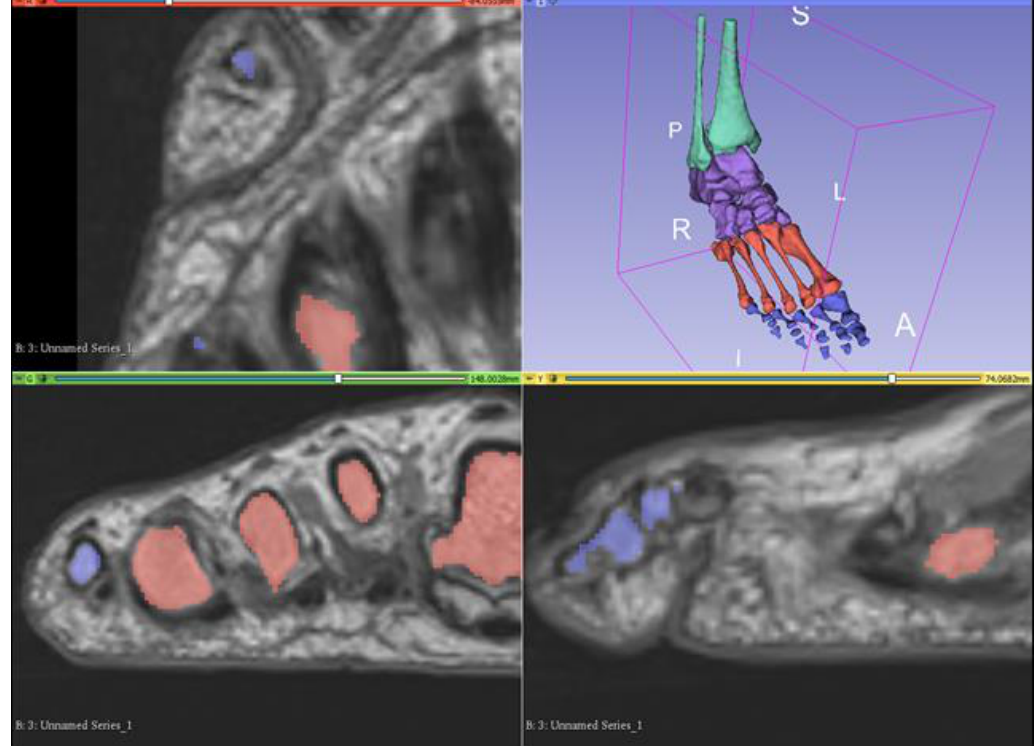
Figure 4. Completed bony model as viewed on the 3D Slicer observation panel. Bones are grouped into leg bones (green), tarsals (purple), metatarsals (red), and phalanges (blue). A-anterior, I-infe- rior, L-left, P-posterior, R-right, S-superior.